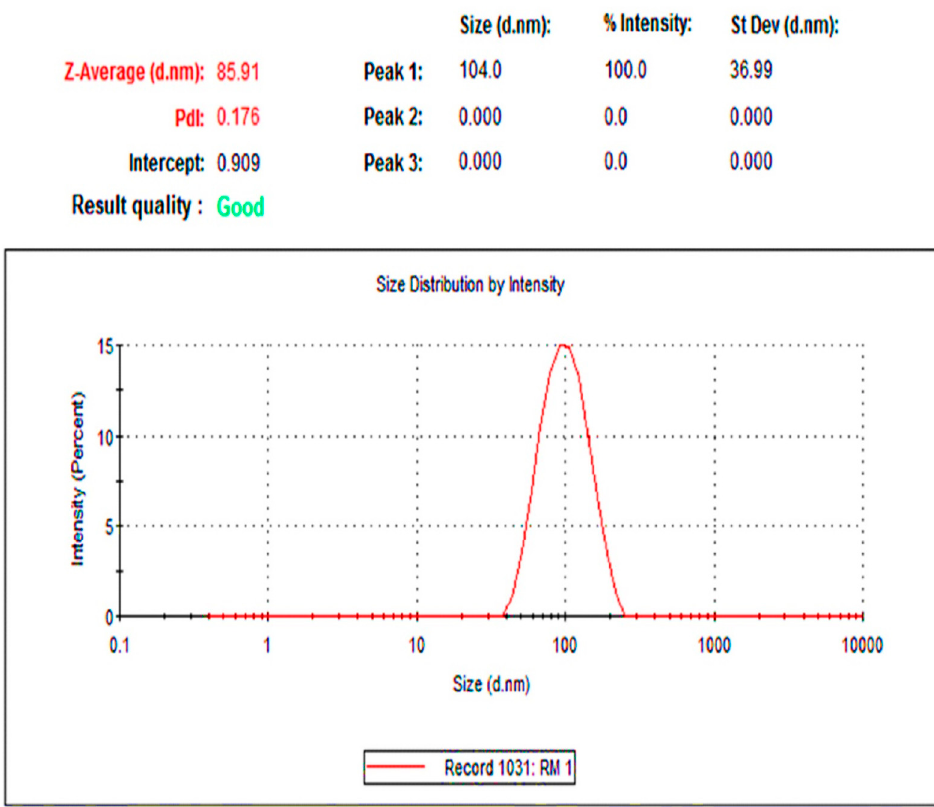
Figure 6. The spectrum obtained by the dynamic light scattering analysis of red currant-AgNPs. The spectrum shows the hydrodynamic diameter (Z-average-d.nm); PDI, polydispersity index.